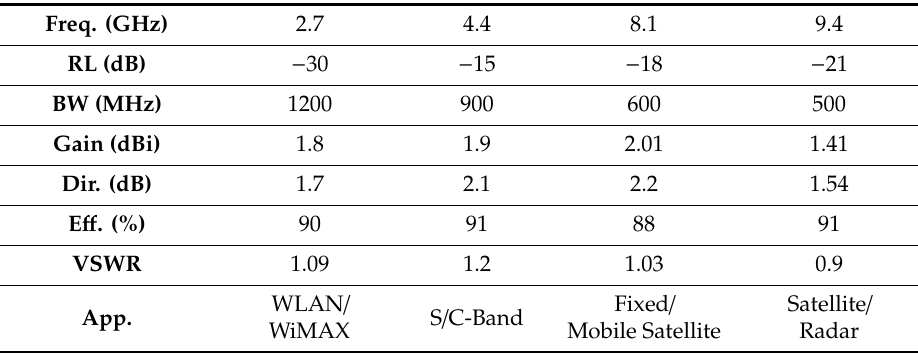
Table 3. Summarized results of Case 1.